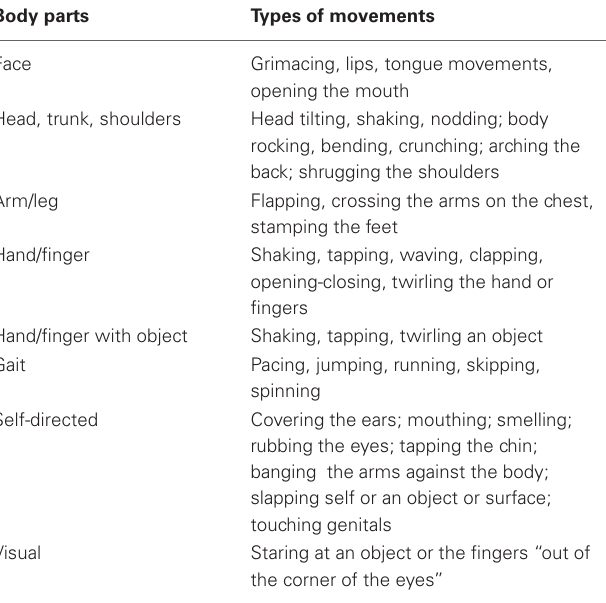
Table 1 | Types of